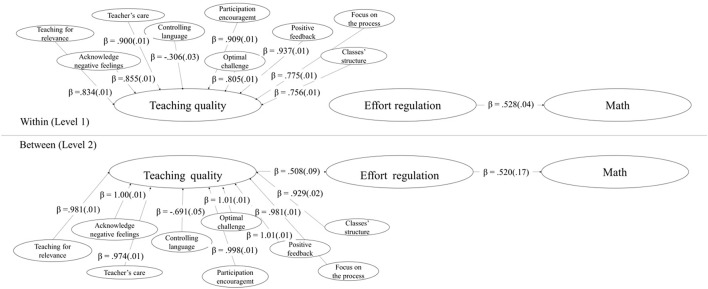
Multilevel structural equation model. All effects are significant (p < 0.001). Standard errors between parentheses.